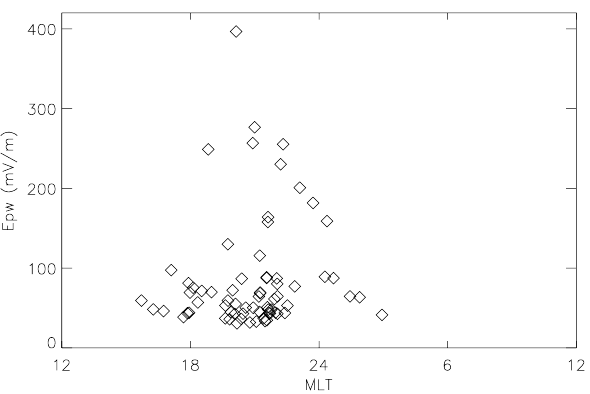
Fig. 2. Distribution of the maximum electric field poleward compo- nent corresponding to a SAID event ( E pw ) versus magnetic local time.